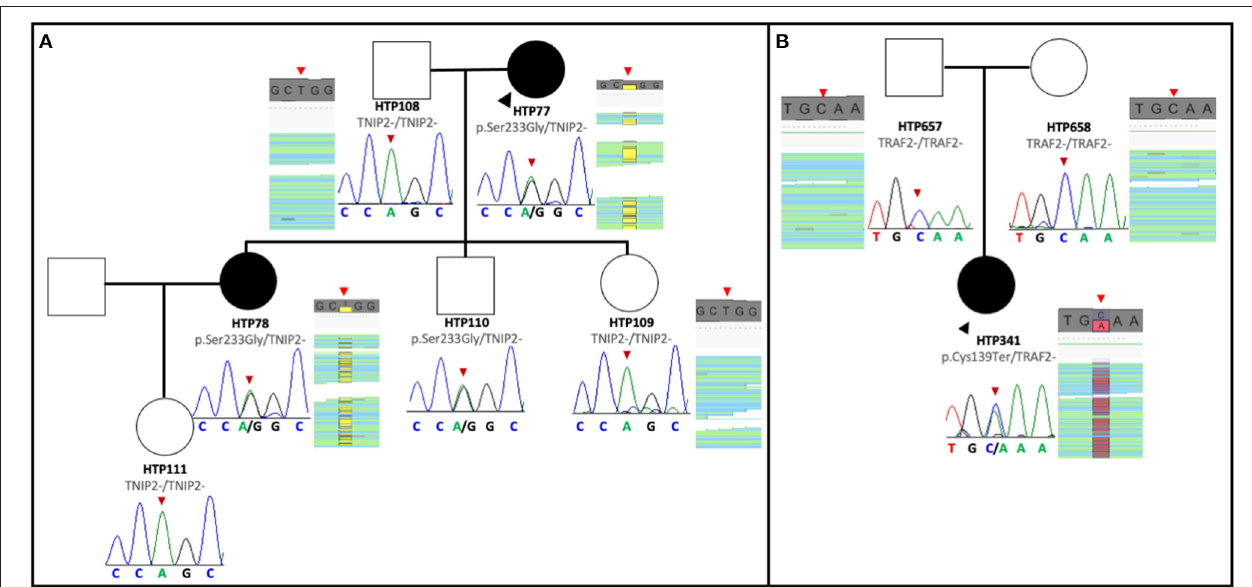
FIGURE 1 | Pedigree of the families with TNIP2 and TRAF2 variants. (A) The TNIP2 variant was found in two affected family members and an unaffected sibling of the proband. Sanger sequencing segregation in all available members is presented, with BAM capture from the IGV software showing the vertical read coverage at the specific position (red arrows). (B) Pedigree of the family with the TRAF2 variant. The nonsense variant was detected only in the proband and confirmed with Sanger sequencing of the variant. BAM capture from the IGV software showing the vertical read coverage at the specific position (red